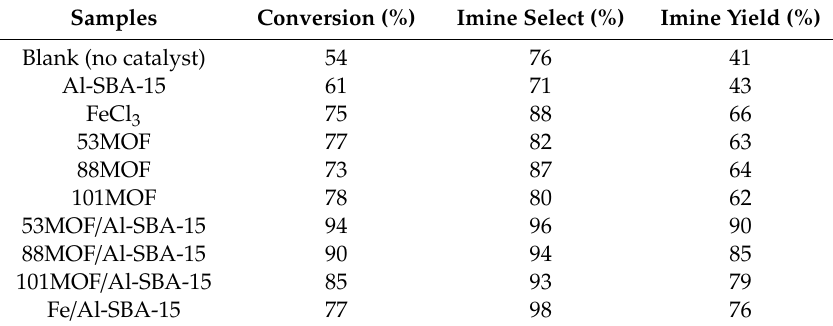
Table 2. N-alkylation of aniline with benzyl alcohol by di ff erent catalysts. Samples Conversion (%) Imine Select (%) Imine Yield (%) Blank (no